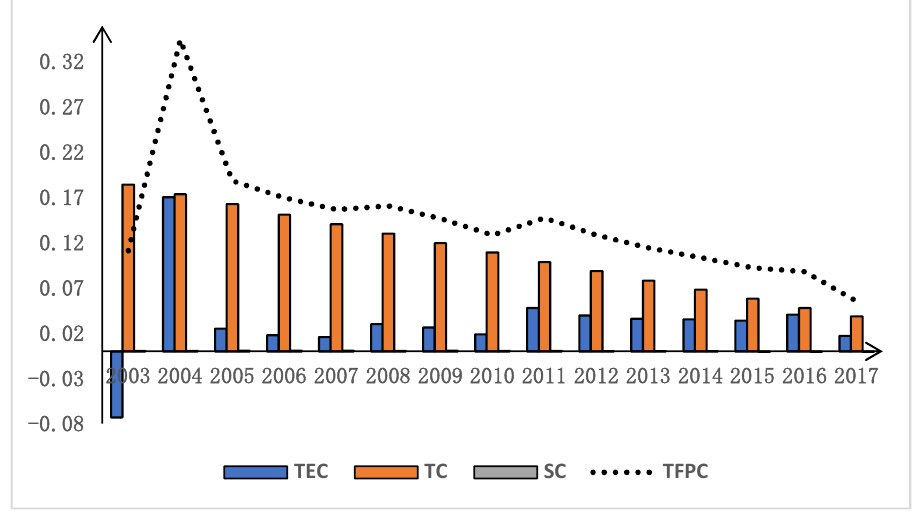
Figure 3. TFP change and its decomposition changes from 2003 to 2017.